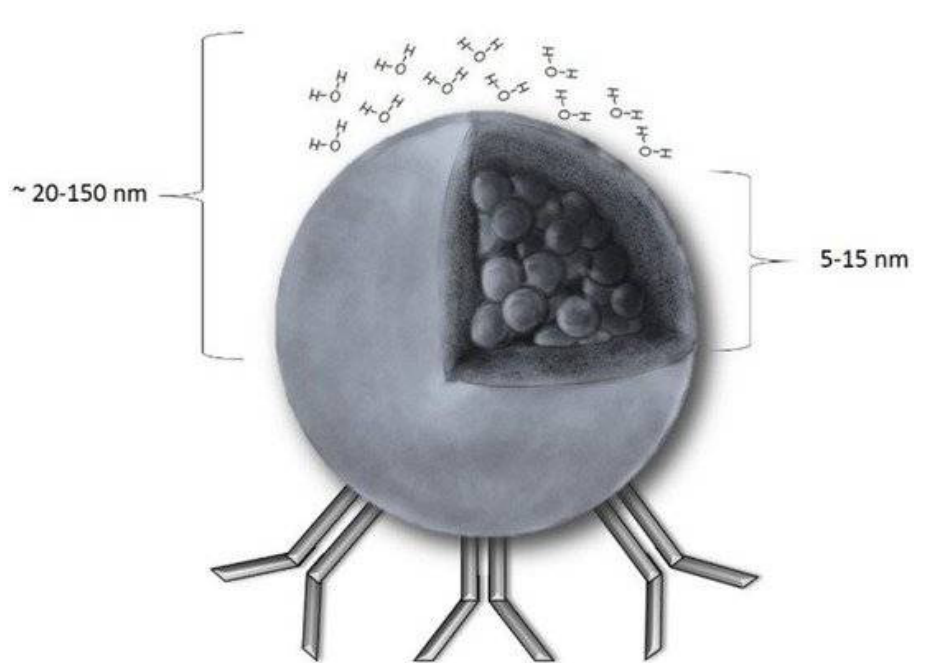
Figure 1. A schematic presentation of a SPION (superparamagnetic iron oxide nanoparticle): The core radius ranges from 5 to 15 nm, and the hydrodynamic radius (core with shell and water coat) is between 20 and 150 nm. Unless there is a magnetic field, magnetisation equals 0. As shown, SPIONs can be easily coupled with antibodies that facilitate the majority of the SPION applications discovered so far [19]. Reproduced with permission from Dulińska–Litewka et al. [19] under a Creative Commons Attribution 4.0 International License.